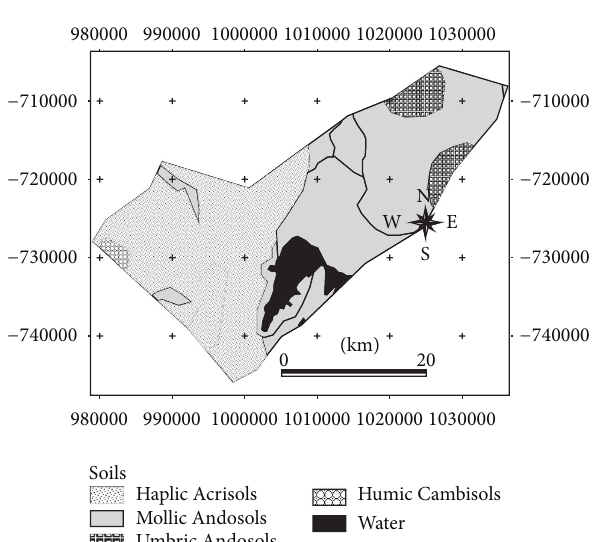
Figure 6: Soils of Mupfuni Shanga benchmarked site (D.R. Congo)